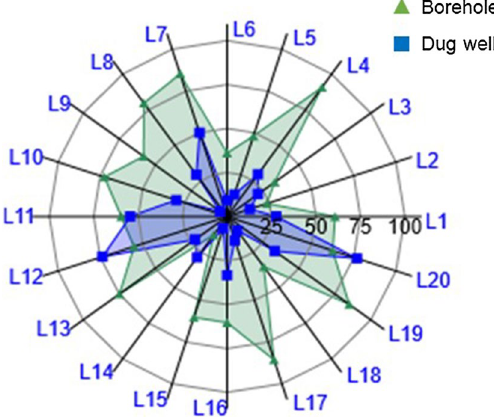
Fig. 15 Radar chart showing the variability of magnesium adsorption ratio between shallow and deep